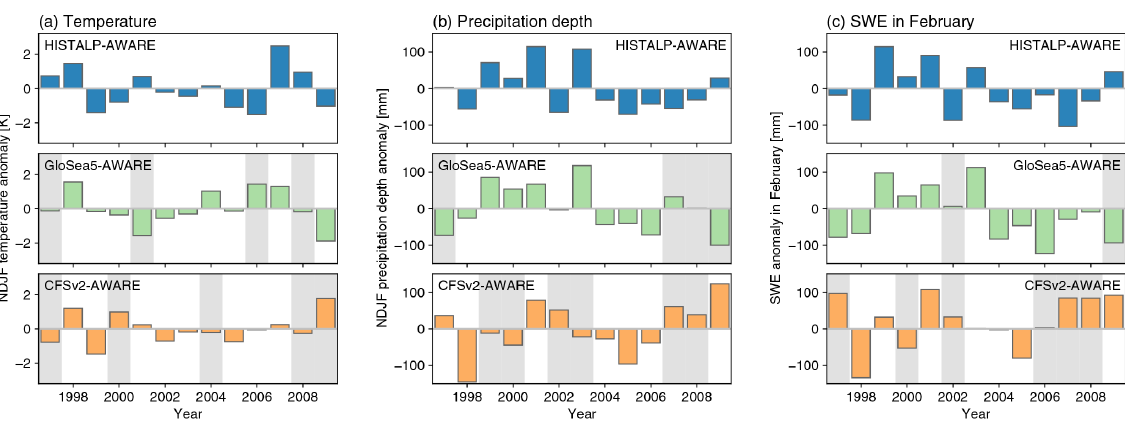
Figure 4. Anomalies of (a) basin-scale NDJF temperature, (b) NDJF areal precipitation depth, and (c) snow accumulation in February. Water balance simulations driven by CM-based seasonal forecasts are compared to water balance simulation driven by HISTALP. Shaded areas indicate years in which the sign of anomalies does not match the reference